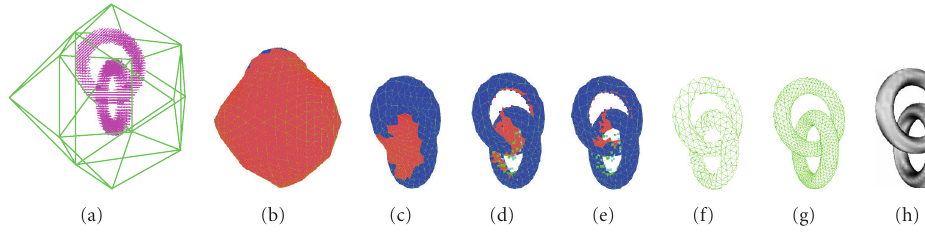
Figure 6: Segmentation of a synthetic volumetric dataset of the union of two disjoint